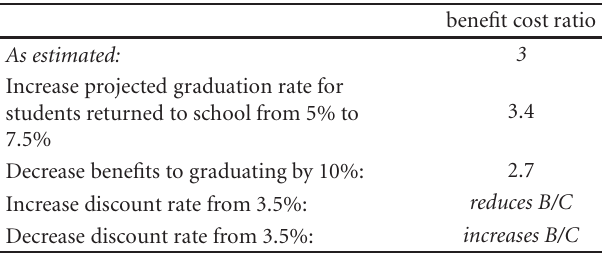
Table 6: Sensitivity analyses benefit cost ratios under alternative assumptions.